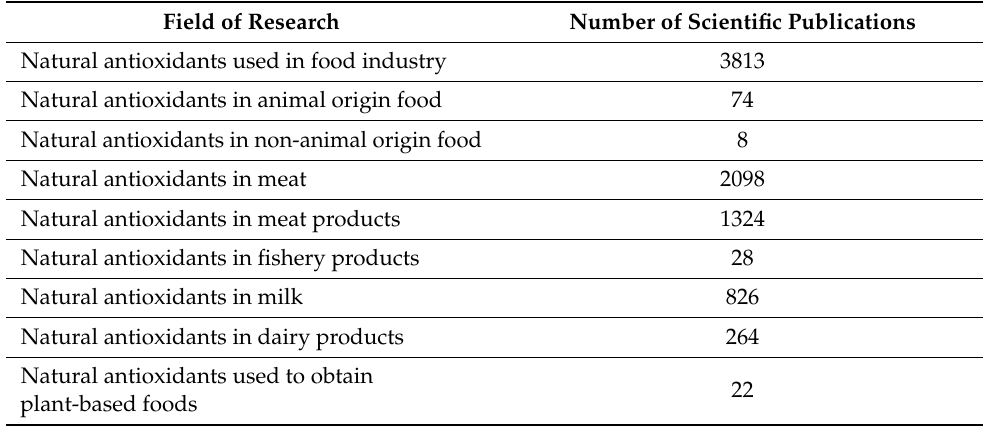
Table 1. Bibliometric analysis according to the “Web of Science”